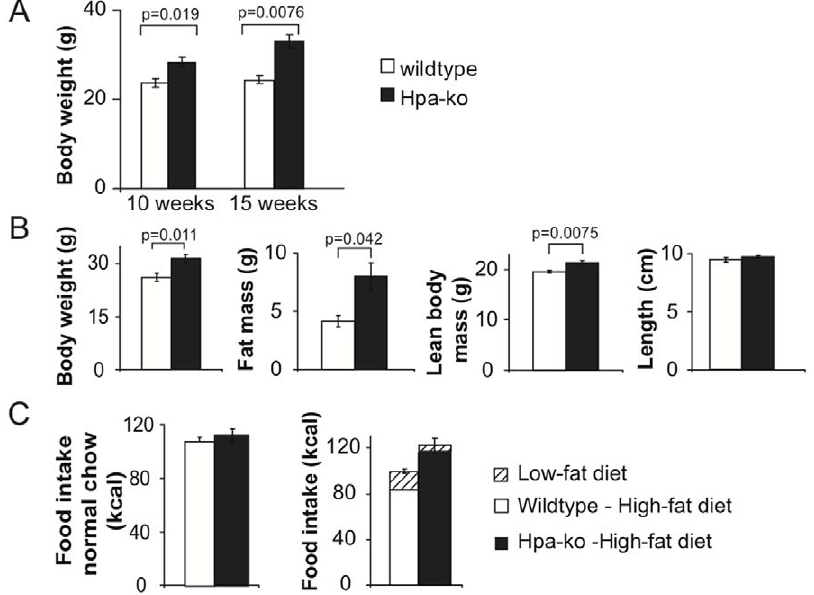
Figure 1. Increased body weight, altered body composition and food intake of Hpa -ko mice. (A) Increased body weight at maturity onset of Hpa -ko mice. Male Hpa -ko mice kept on normal chow showed increased body weight compared to wt sibling controls, discernible from 10 weeks of age (wt, n=7; Hpa- ko, n=20) and more pronounced at 15 weeks of age (wt, n=5; Hpa- ko, n=17). (B) Increased fat mass and lean body mass of Hpa -ko mice. DEXA analysis of 21-week old animals showed larger fat mass and lean body mass in Hpa -ko mice (n=7) than in controls (n=4). There was no difference in body length. (C) Increased food intake of Hpa -ko mice on high-fat diet but not on normal chow. Hpa -ko and wt control mice, age 10–15 weeks, were given either normal chow ( left panel) or offered a choice between low-fat diet and high-fat diet during one week ( right panel ). No difference was seen between the two groups (wt, n=6; Hpa -ko, n=7) on normal chow. Hpa -ko mice (n=7) ate significantly more of the high-fat diet (expressed as kcal/one week; p=0.04) and more overall (p=0.019) than wt controls (n=5), whereas consumption of low-fat diet did not differ significantly between the groups.